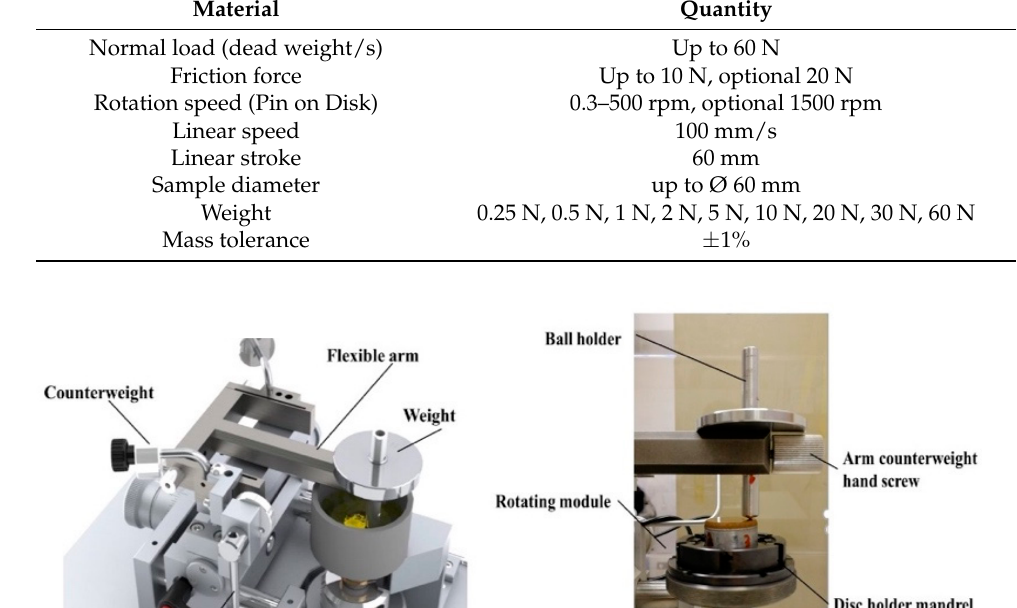
Figure 3. Microscopical section view of diamond distribution in DMMC ( left ) and D30 ( right ) coatings.